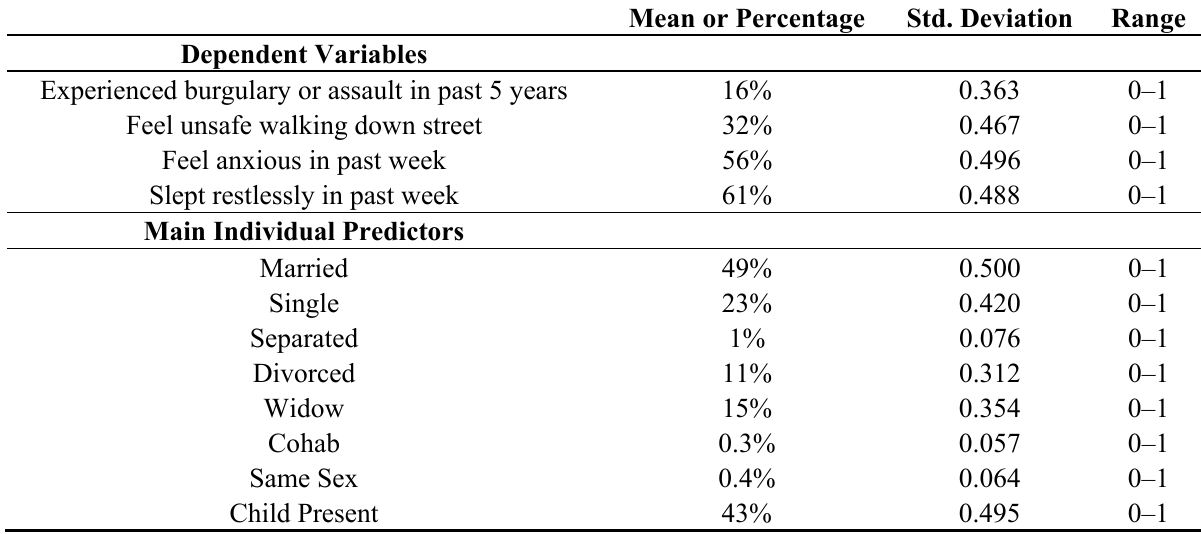
Table 1. Descriptive statistics of dependent and independent variables (ESS n = 28,768)